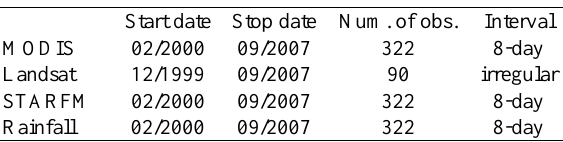
Table 1. Time span and resolution of the raster data used. NDVI data were extracted from this time series of STARFM generated Landsat type imagery as a representation for